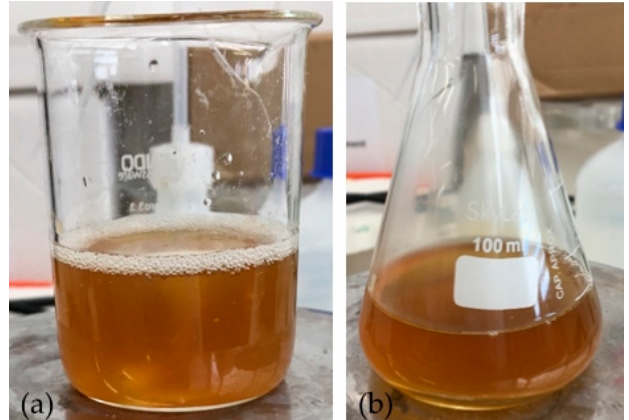
Figure 3. Solution of arabinoxylan (2% w / v ): ( a ) before the addition of activated charcoal (2% w / v ) and ( b ) after 1 h of contact.